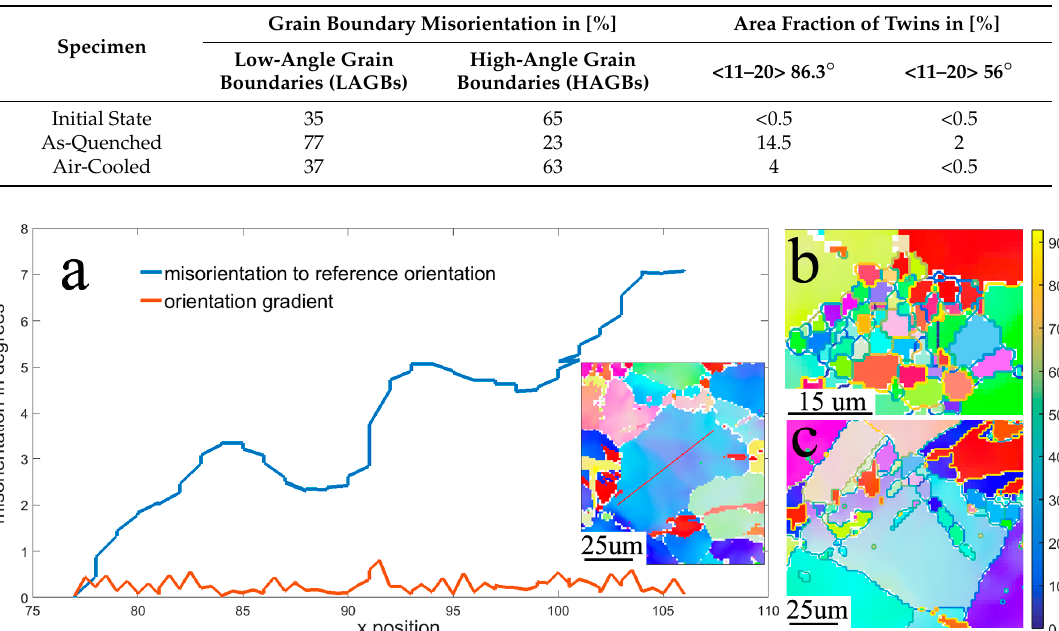
Figure 5. Twin analysis in the as-quenched specimen, based on ( a ) kernel-average misorientation (KAM) plot; In ( b ) is an enlarged region of interest (ROI) of a coarse grain containing a twin; ( c – e ) transmission-electron micrograph (TEM) near weak-beam dark-field (WBDF) conditions and conventional DF, showing dislocations threading the matrix and the twins, high density of dislocations within the twin lamella and dislocation network at the TBs. In order to investigate the deformation mechanism in more detail, the (0002) pole figures (PFs) in the initial state, as-quenched and air-cooled specimens are shown in Figure 3g–i, respectively. The PF intensities are presented in multiples of random distribution (MRD). At the initial state, a typical extrusion texture with a characteristic fiber axis parallel to the ED is observed ( c -axes perpendicular to the ED) [5]. The intense (0002) pole density is located parallel to the TD (Figure 3g). In the as-quenched specimen, the basal texture decreases (from 9.6 MRD to 7.4 MRD), with some rotations of c -axes from the orientation perpendicular to the ED towards orientation parallel to the ED (Figure 3h). The texture modification can be traced to several processes: the high-volume fraction of < 112 (cid:3364) 0 > twins, which are activated during the expansion test, the subdivision of grains found inside the coarse ones, and the nucleation of randomly oriented, recrystallized grains. The obtained texture in the air-cooled specimen resembles to that shown for the initial state, with 9.7 MRD density of the (0002) parallel to the TD. Still, traces of the texture found in the as-quenched specimen are not completely eliminated (Figure 3i). This analysis is compatible with the results of the areal fraction of the twins prior and post expansion test (Table 1). One possible explanation for the strengthening of the basal texture in the air-cooled specimen is that it is a consequence of the mixed-mode deformation